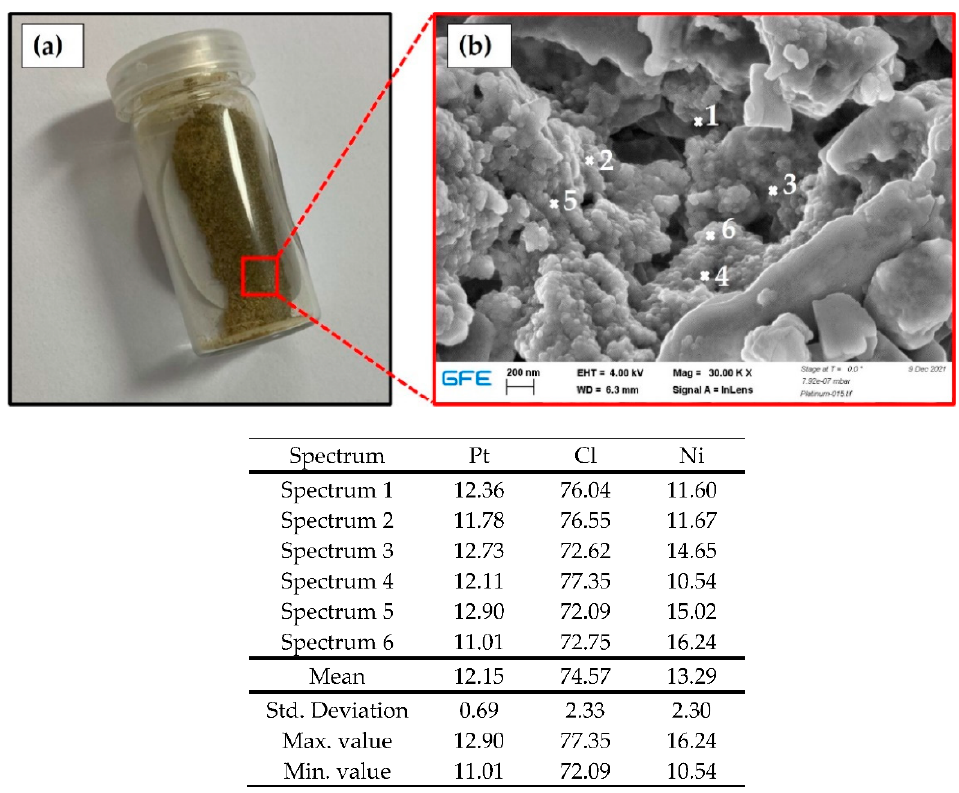
Figure 6. XRD analysis of the formed precipitate as residues by dissolving the cast alloy.